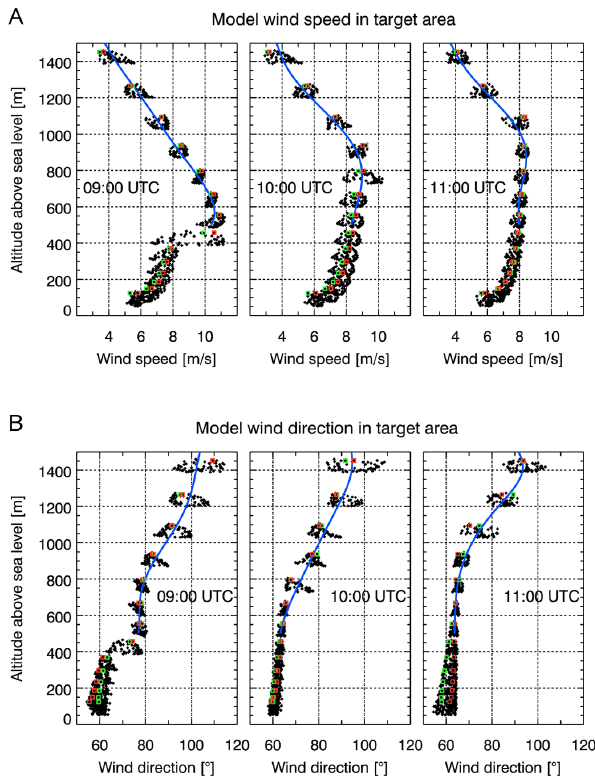
Fig. 7. Wind speed (panel A ) and direction (panel B ) from the COSMO-DE model throughout the measurement area as shown in Fig. 1. Red squares denote data from the location east of Theodor Shaft and green squares data east from Bockraden Shaft. The blue line indicates a sixth-order polynomial fit from about 500m to 1500m corresponding to flight altitudes during the survey.